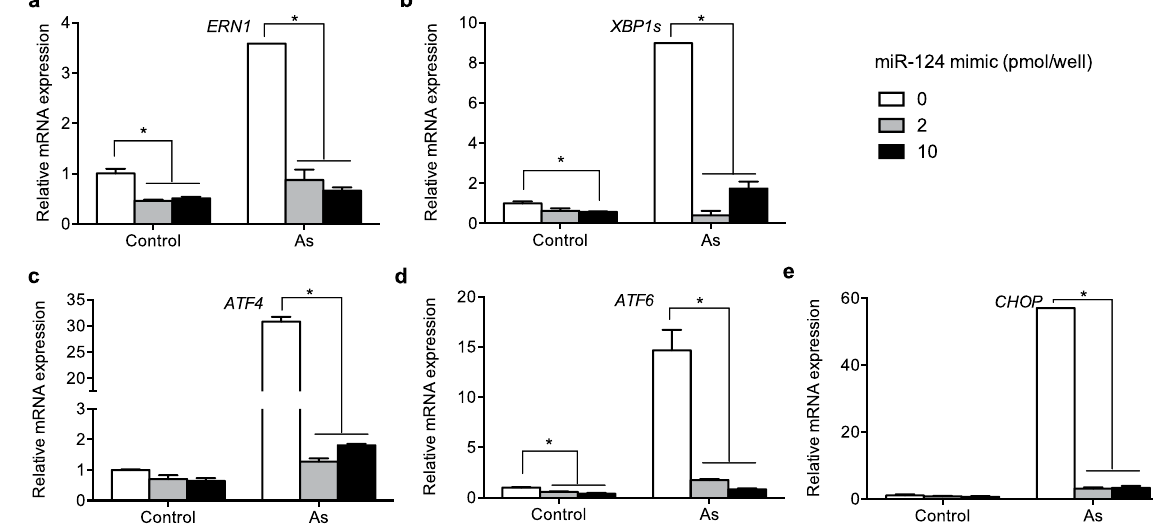
Figure 2. Mir-124 suppresses As-induced activation of three UPR pathways in human neural cells ( a–e ) Effect of miR-124 on As-induced ER stress response. ReNcell Cx neuroprogenitor cells were transfected with scramble or miR-124 mimic (5 pmol or 10 pmol/well), then exposed to 10 μ M As for 4 h. Expression of ERN1 (gene encoding IRE1), XBP1s (spliced XBP1), ATF4, ATF6 and CHOP was measured by qRT-PCR. N = 3 experiments. All error bars represent the standard error of the mean of two biologic replicates. * p <